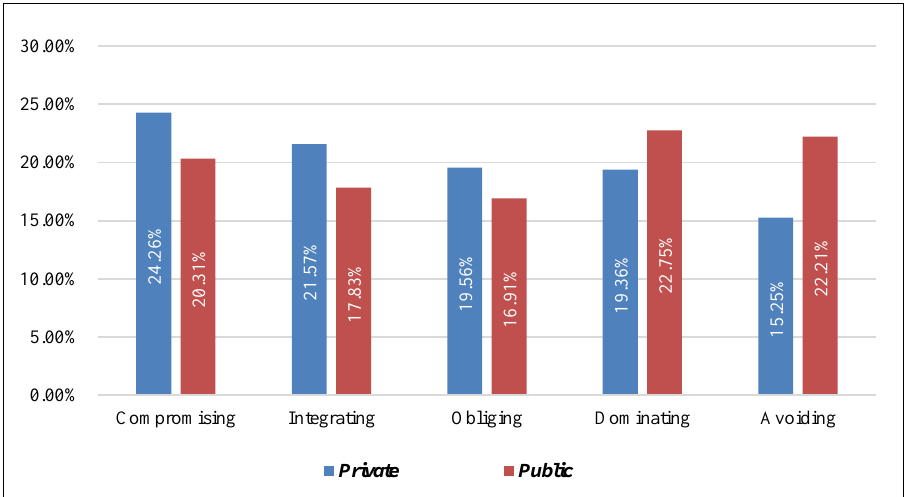
Figure 5. Comparison of conflict management styles by business